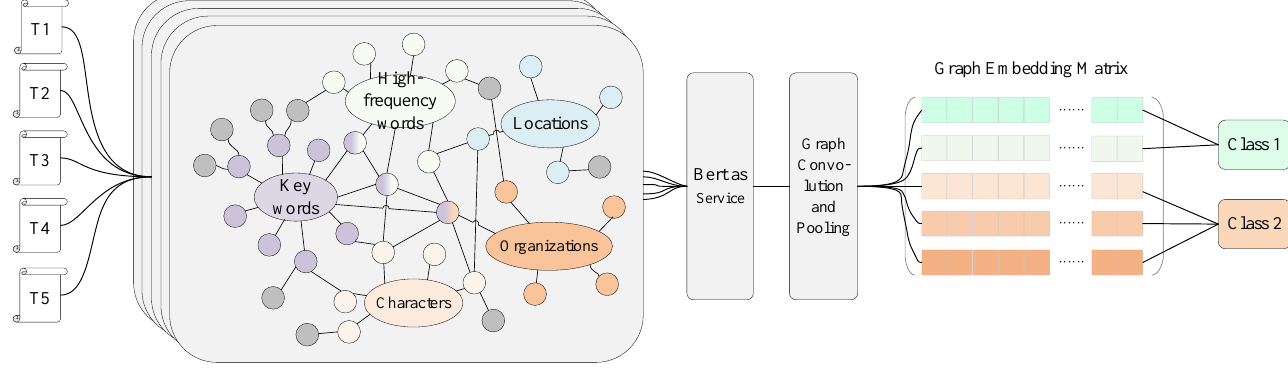
Figure 1. Schematic of our method. There are five news texts for